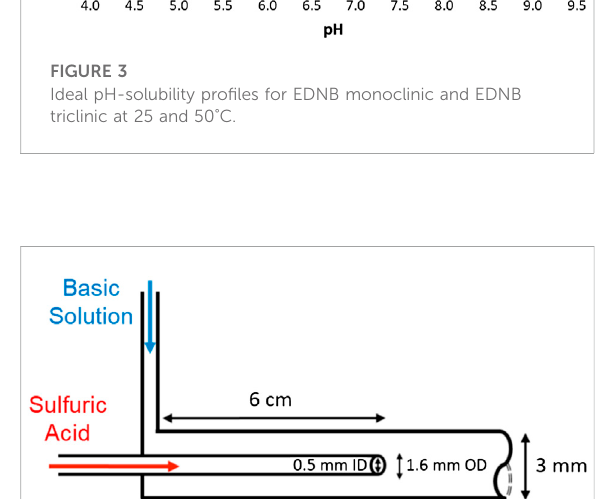
FIGURE 4 Co-axial mixer diagram with dimensions